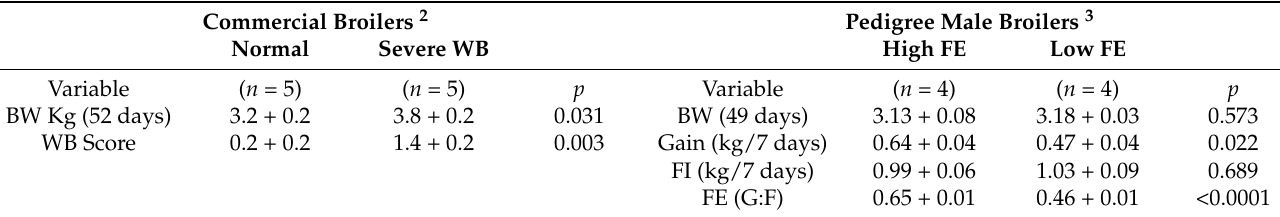
Table 1. Body weights (BW) and wooden breast (WB) scores in commercial broilers with and without WB, and BW, weight gain (Gain), feed intake (FI) and feed efficiency (FE, gain to feed) in Pedigree Male broilers from which shotgun proteomics was conducted on breast muscle tissue 1